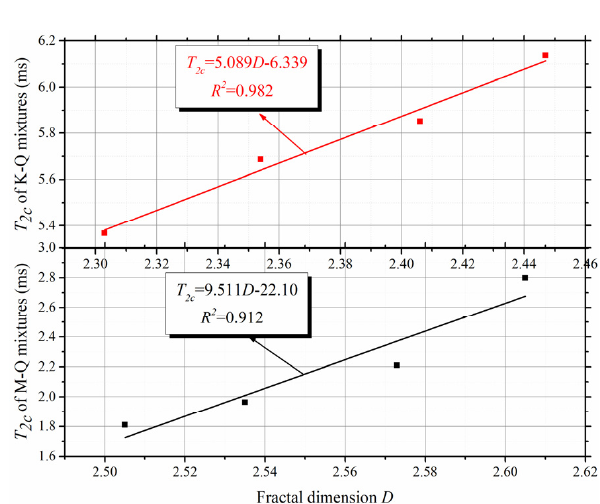
Figure 14. The relationships between T 2 c and fractal dimensions ( D ). The lines at the top and bottom indicate the relationships between T 2 c and D of kaolinite-quartz (K-Q) and montmorillonite-quartz (M-Q) mixtures, respectively. The Equations in the two boxes are the Equations of the two lines. R 2 indicates the correlation coefficient of the Equation.